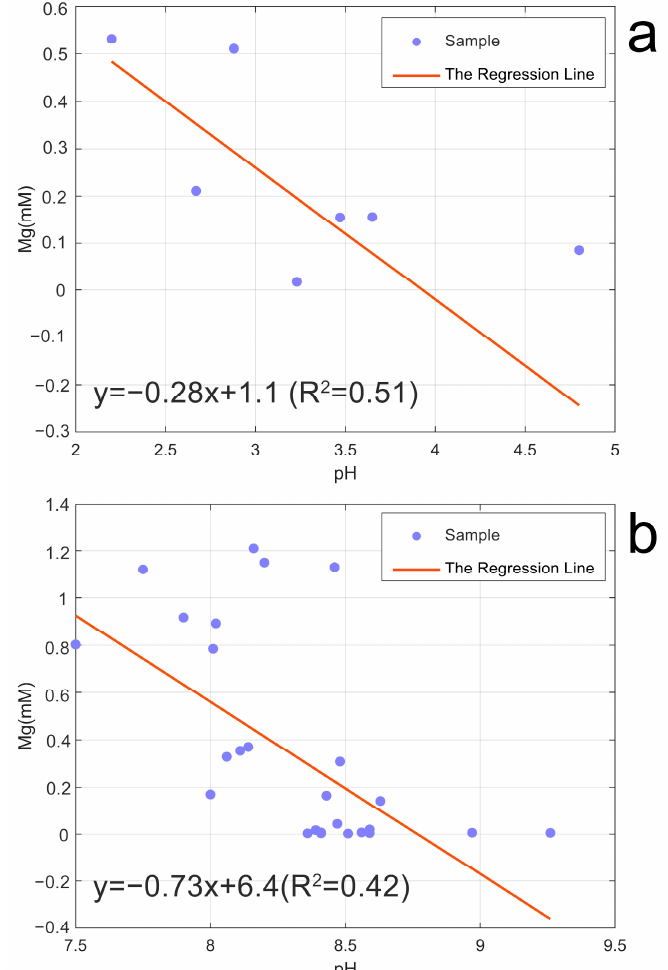
Figure 6. ( a ) Plot of Mg vs. pH (acidic); ( b ) plot of Mg vs. pH (alkaline).